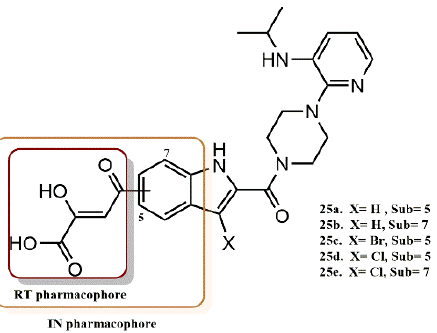
Figure 21. RT and IN pharmacophores of new active synthesized compounds 25a-e .